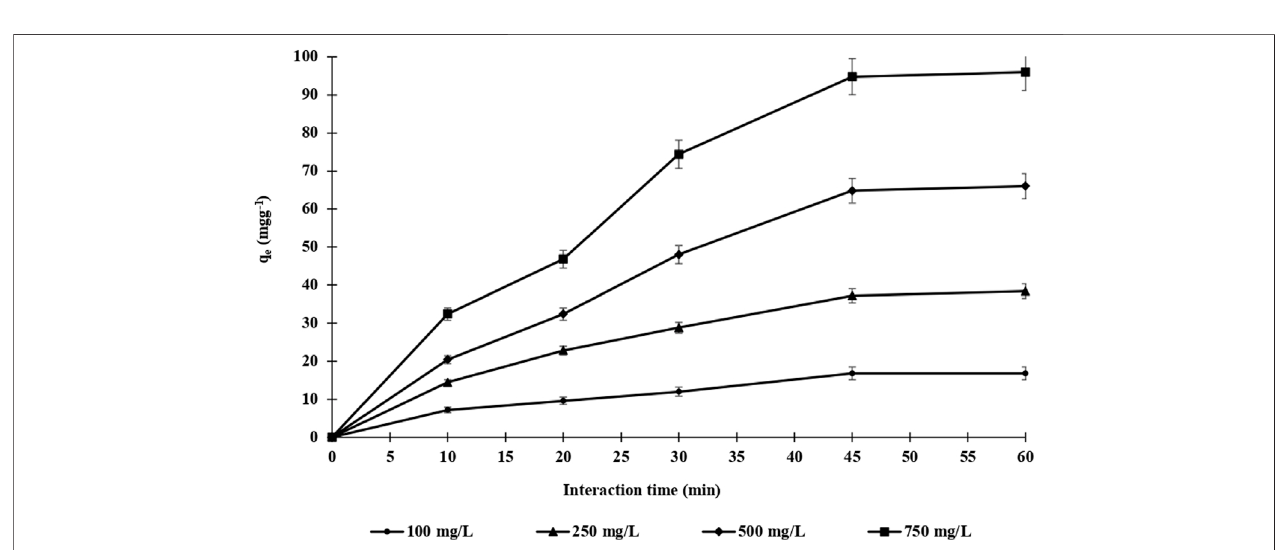
FIGURE 6 | The effect of initial endosulfan concentration on the adsorption capacity of m-DE-APTES.